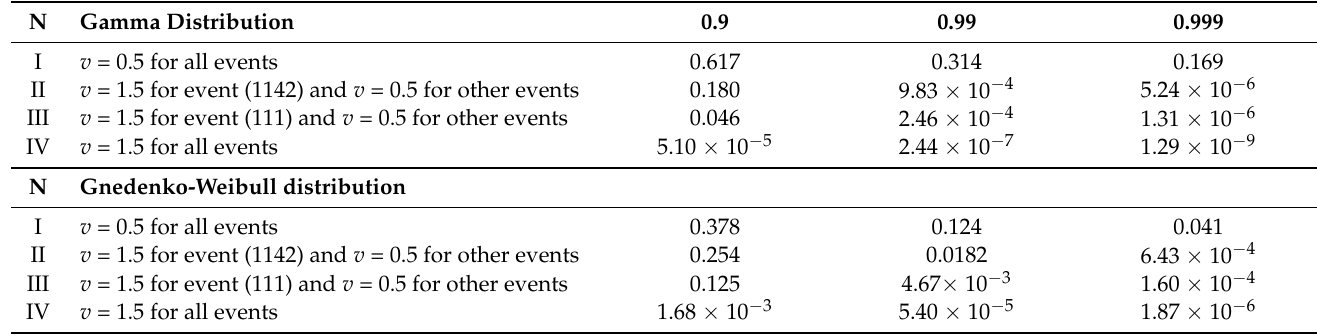
Table 3. Quantiles of reliability functions for Gamma and Gnedenko-Weibull EOT